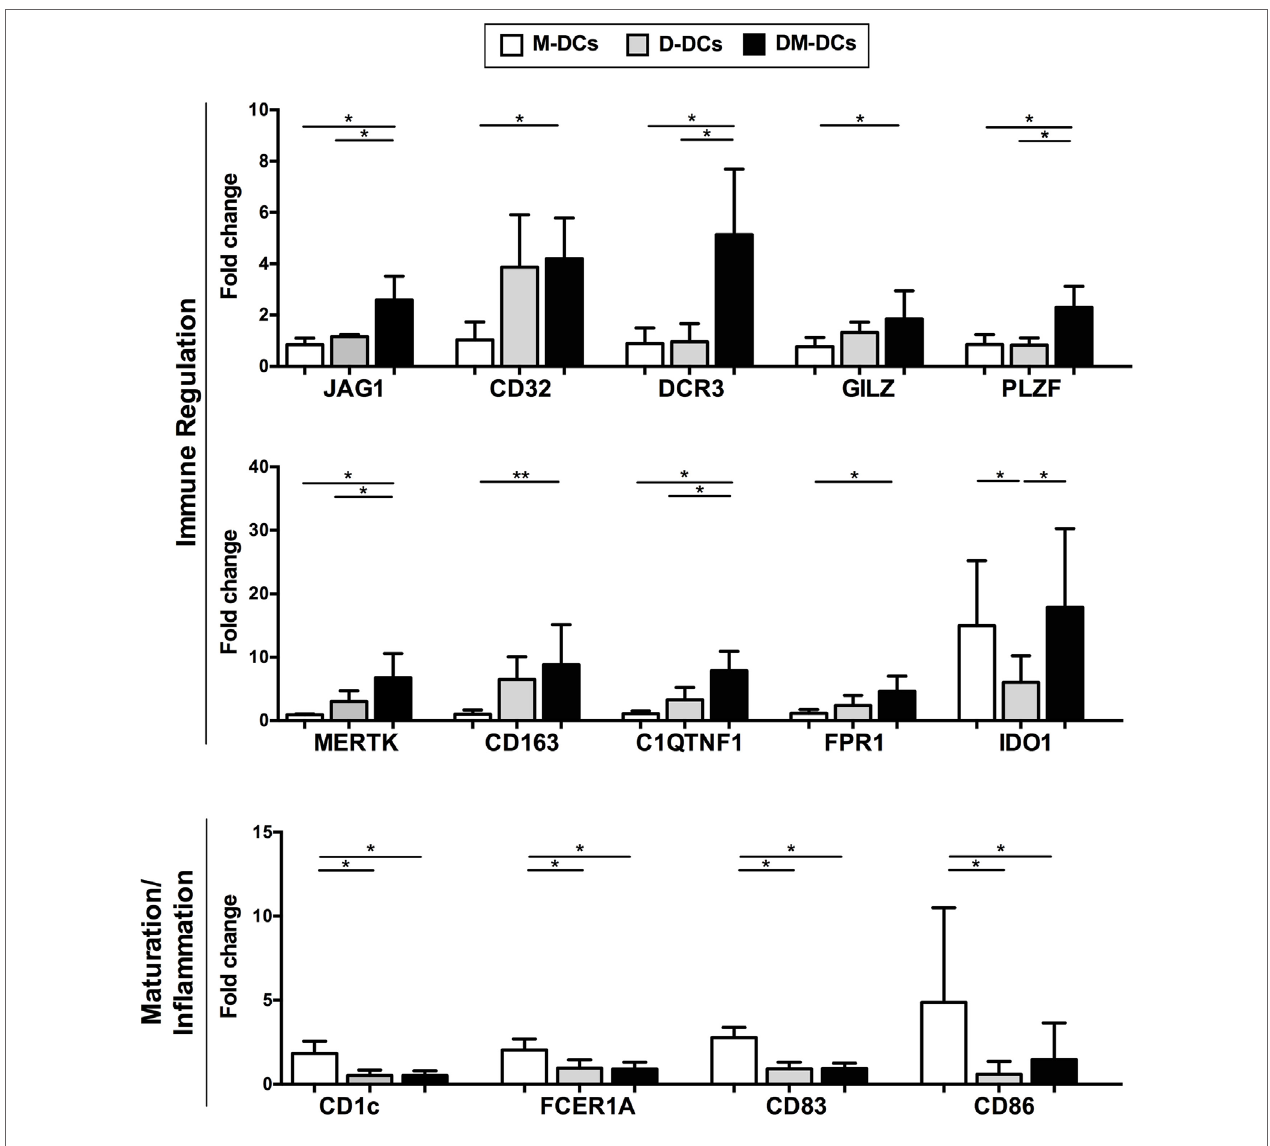
FigUre 6 | Changes in gene expression induced by dexamethasone and monophosphoryl lipid A are translated at the protein level. Protein levels of genes related with tolerance induction and monocyte-derived dendritic cells (DCs) activation were assessed by flow cytometry analysis. Results are shown as fold change values with respect to the untreated control (DCs). Data represent mean ± SD for five independent experiments. * p -value ≤ 0.05; ** p -value ≤